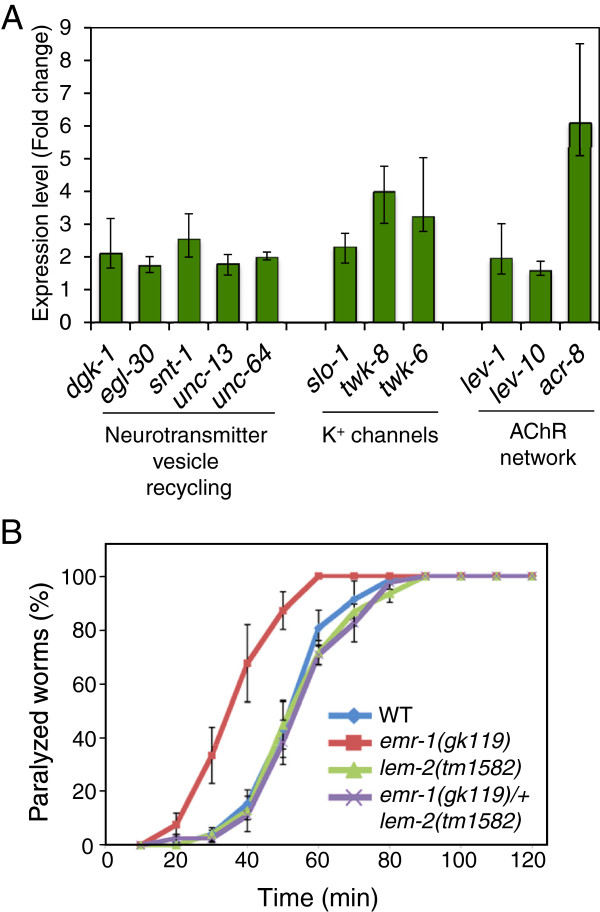
Synaptic function is altered in emr-1 mutants. (A) Fold increase in expression of selected genes involved in synaptic transmission in emr-1(RNAi) lem-2(tm1582) animals. Error bars indicate minimum and maximum values. (B) Aldicarb sensitivity experiments in wild type (WT), emr-1(gk119), lem-2(tm1582) and emr-1(gk119)/+ lem-2(tm1582) mutants. Synaptic function was evaluated based on paralysis induced by the cholinesterase inhibitor aldicarb. Data points show the mean of four experiments and error bars indicate standard error of the mean.